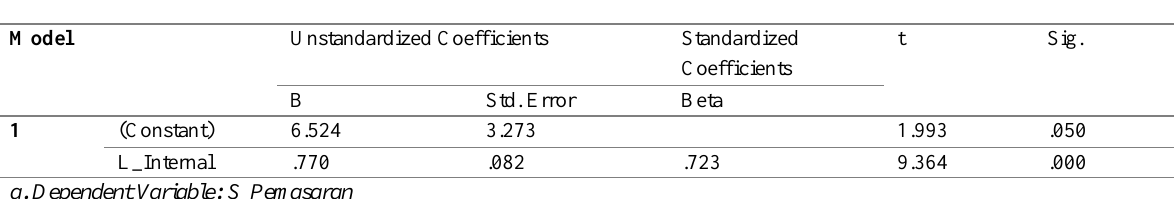
Table 5: Test Result t-Statistic Model structure I